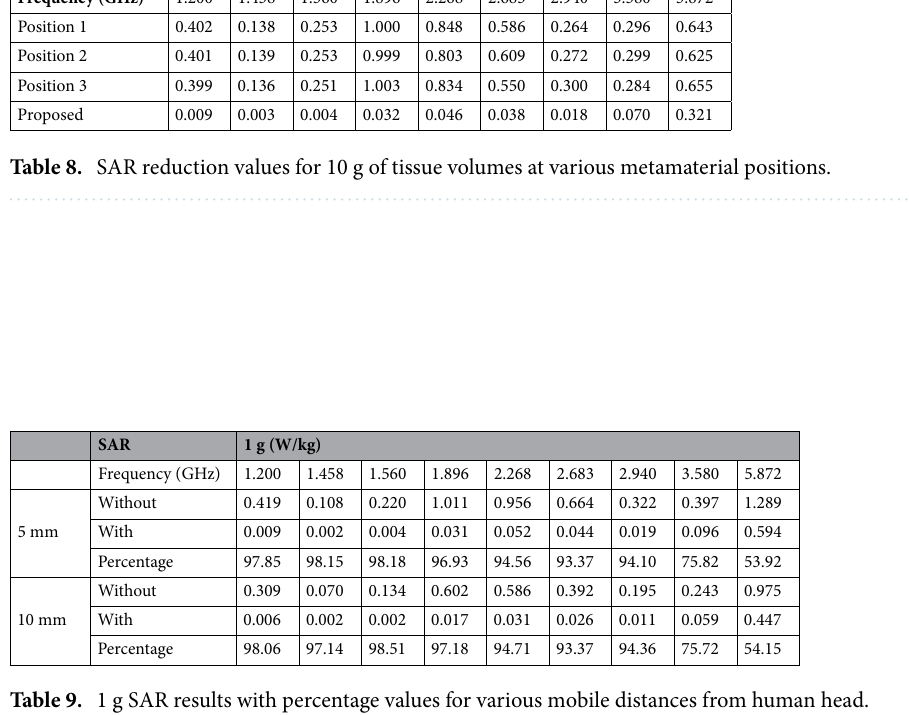
Table 9. 1 g SAR results with percentage values for various mobile distances from human head.